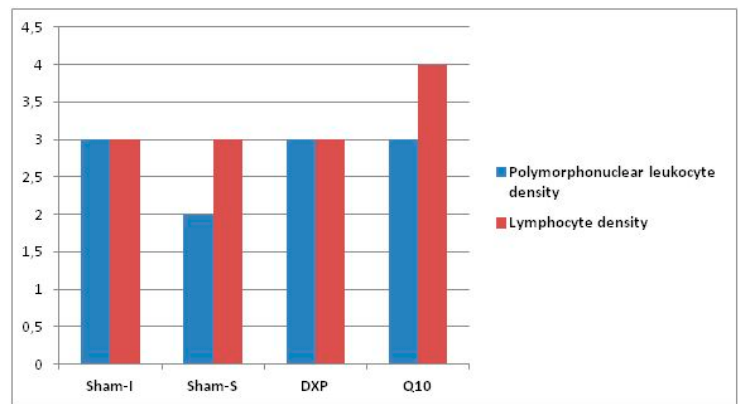
Figure 8. Bars represent the polymorphonuclear leukocyte density and lymphocyte density score